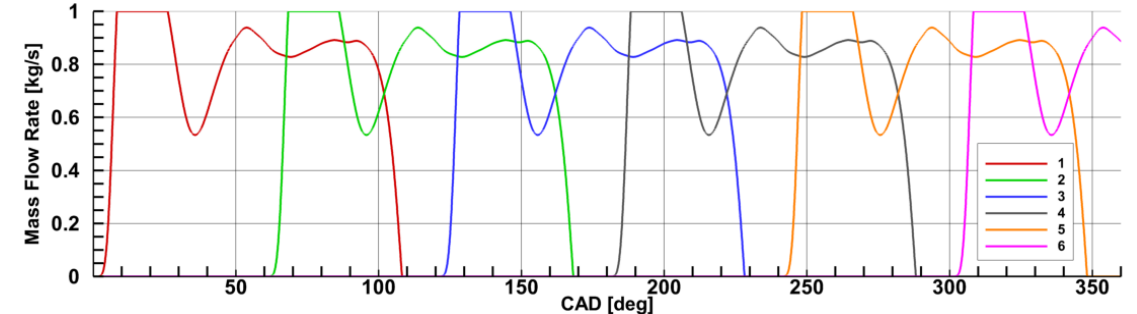
Figure 6. The inlet mass flow rate profile.